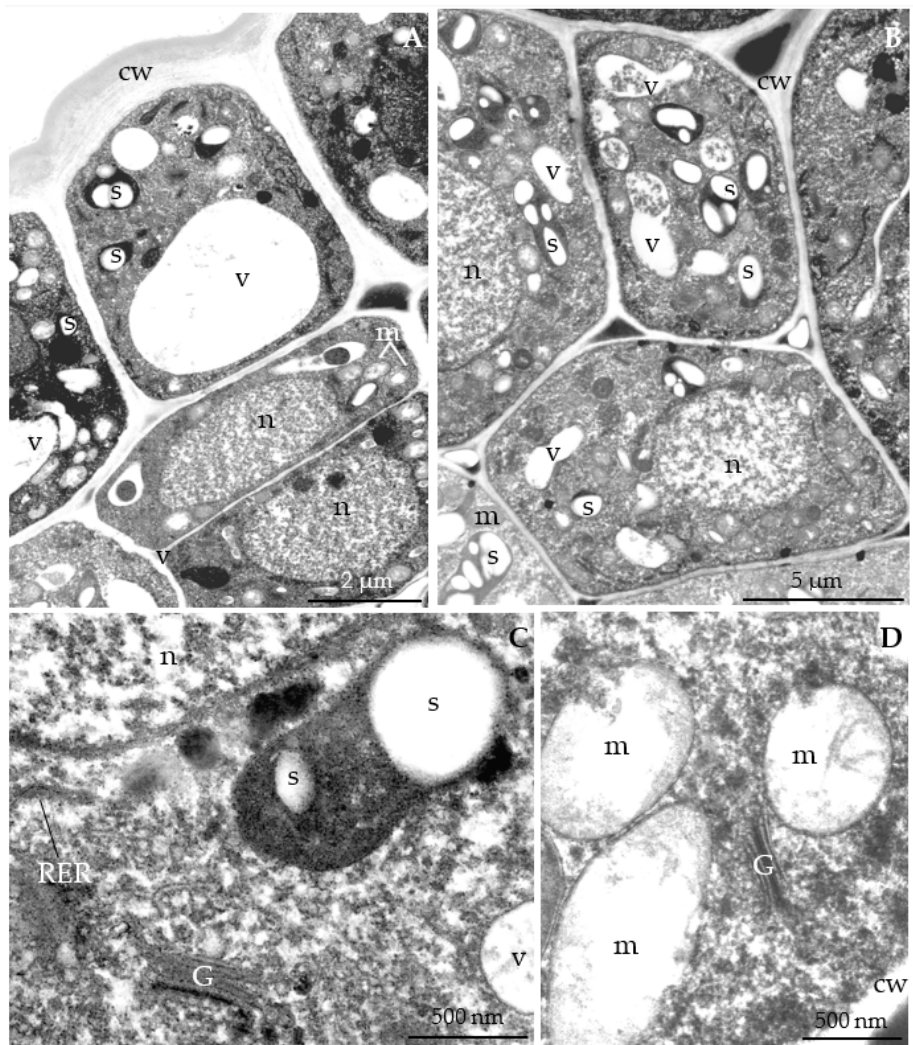
Figure 11. ( A – D ). Fragments of nectary epidermis ( A , C ) and parenchyma ( B , D ) cells in R. idaeus ‘Glen Ample’ in the initial secretion phase. ( A , B ): slight vacuolization (v) of epidermis cells, starch grains (s) in amyloplasts, centrally located large cell nucleus (n), small vacuoles in parenchyma cells (v). ( C ): starch grains (s) in plastid, Golgi apparatus (G), nucleus (n), rough endoplasmic reticulum (RER). ( D ): mitochondria (m) located near the cell wall (cw), Golgi apparatus (G).